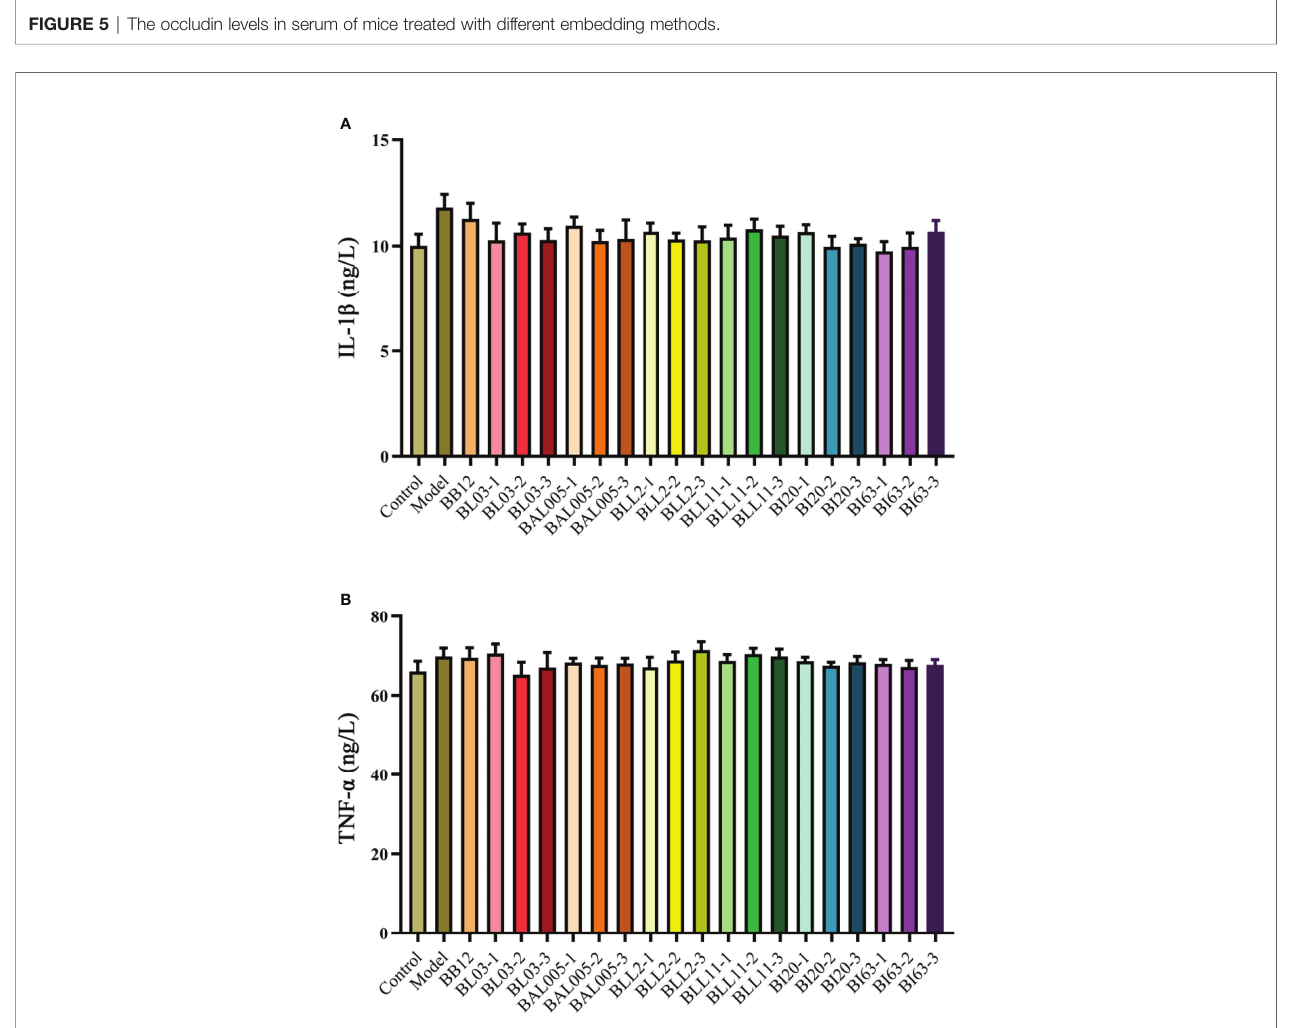
FIGURE 6 | The levels of IL-1 b (A) and TNF- a (B) in serum of mice treated with different embedding